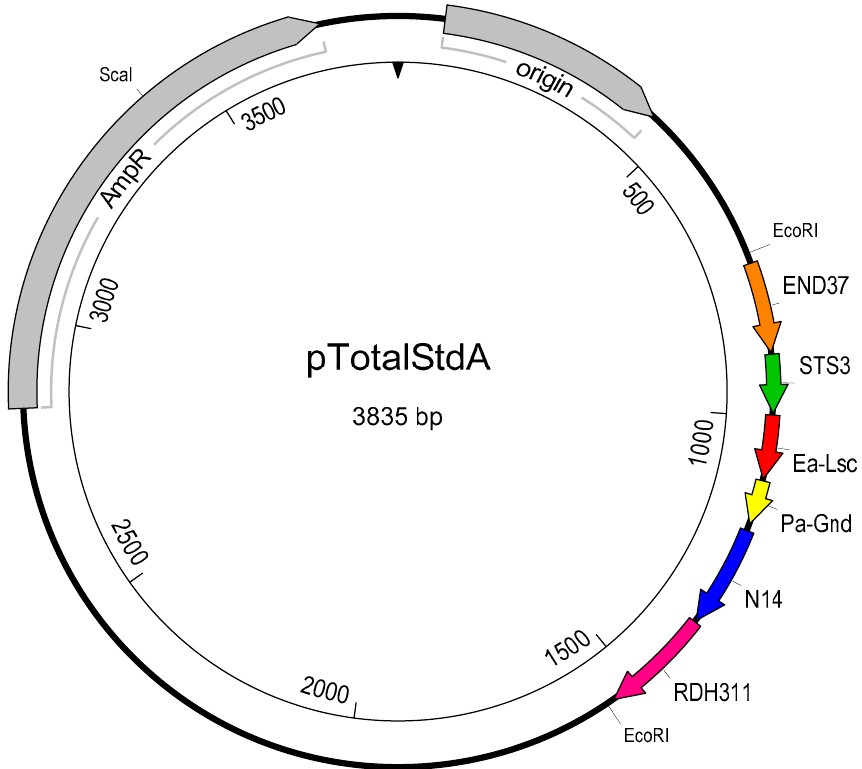
Figure 1. Plasmid map of pTotalStdA used in all quantitative PCR reactions to quantify wild type global isolates of E. amylovora (Ea-Lsc, red), P. agglomerans (Pa-Gnd, yellow), and the four phage species Erwinia virus Ea214 (END37, orange), Erwinia virus Ea35-70 (RDH311, pink), Erwinia virus Era103 (STS3, green), and Erwinia virus Ea9-2 (N14, blue).